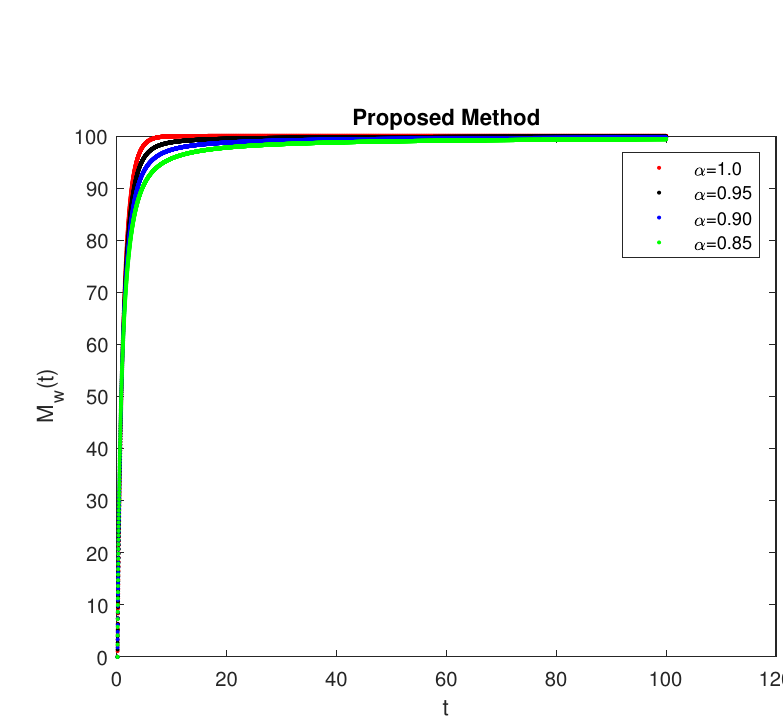
Figure 18: Numerical simulations for τ = 0.9 for Caputo